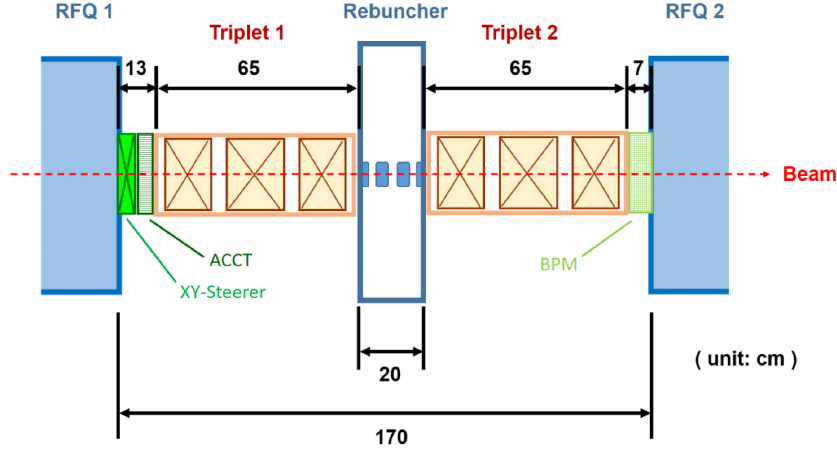
FIG. 11. Schematic plot of the connection between two RFQs with an